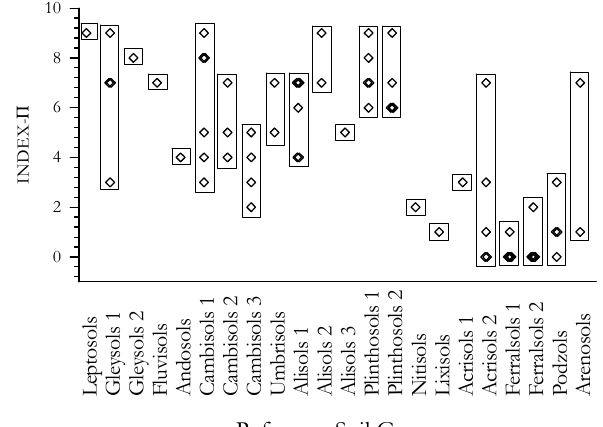
Fig. 13 Fig. 13. Variation in the index of physical properties ( 5 ) along the soil age gradient. Bars represent the variability within soil groups, and thicker and darker marks reflect many data points sharing the same score.